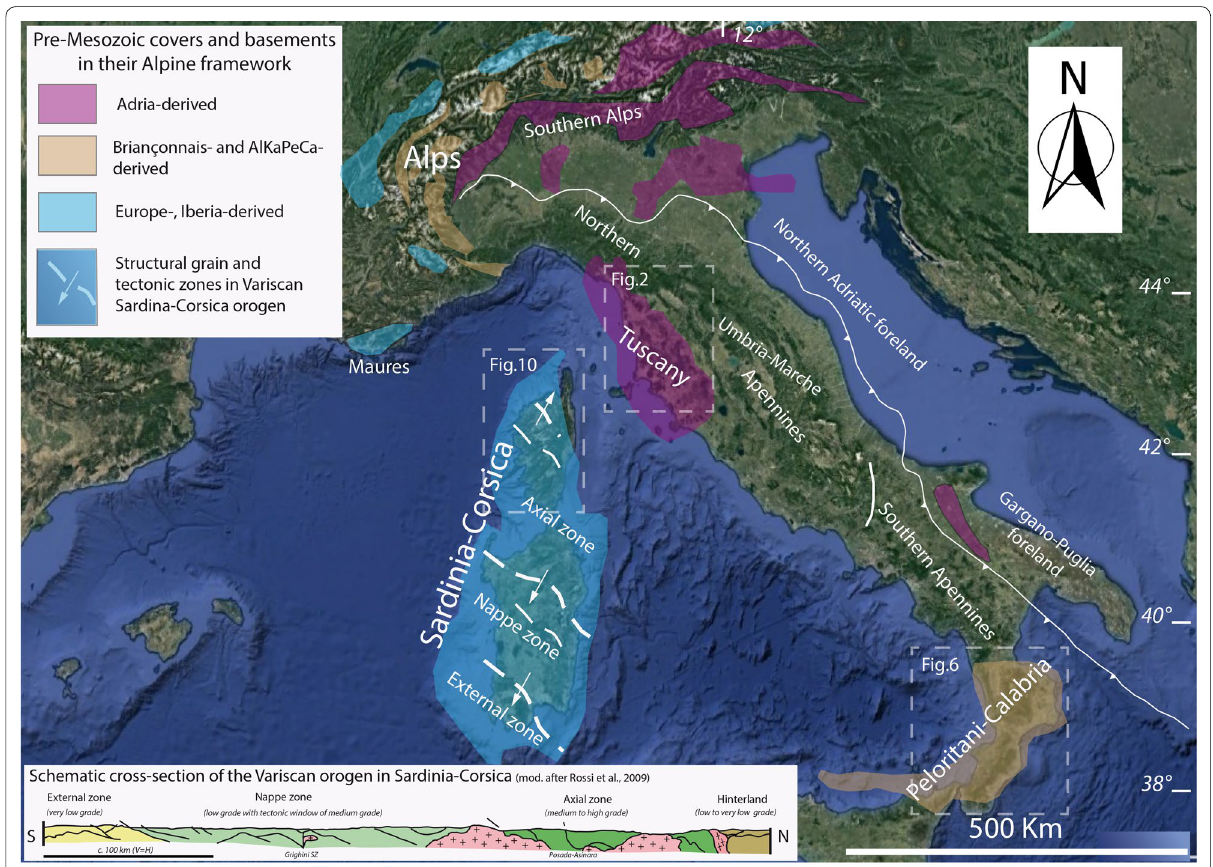
Fig. 1 Exposure or shallow subsurface (minor than 6 km) occurences of pre-Mesozoic covers and basements in Central Mediterranean. The colors in the map are related to their Alpine framework and respectively referred to the Adria, Briançonnais /AlKaPeCa and European/Iberian domains (Schmid et al. 2004; Handy et al. 2010). The main tectonic zones (with arrows indicating the tectonic transport directions) are reported for the Sardinia-Corsica Variscan orogen as also figured in the general and schematic cross-section after Rossi et al. (2009). Google